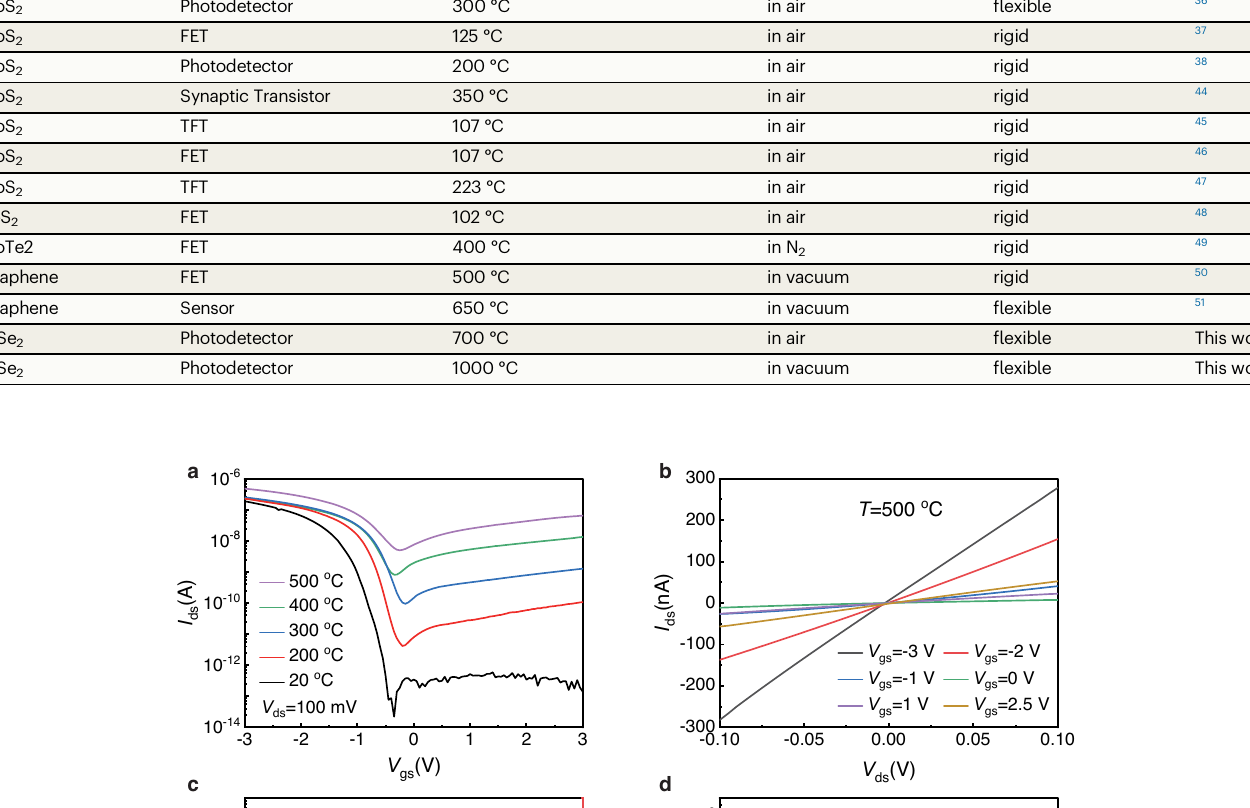
Table 1 | Comparison of temperature tolerance in different 2D material devices Device